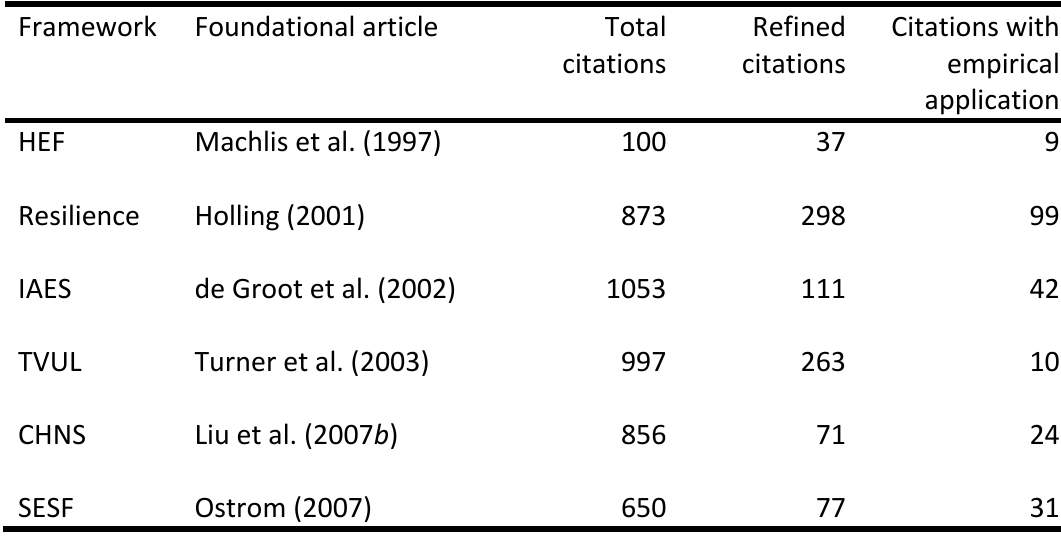
Table A1.1. Citation metadata